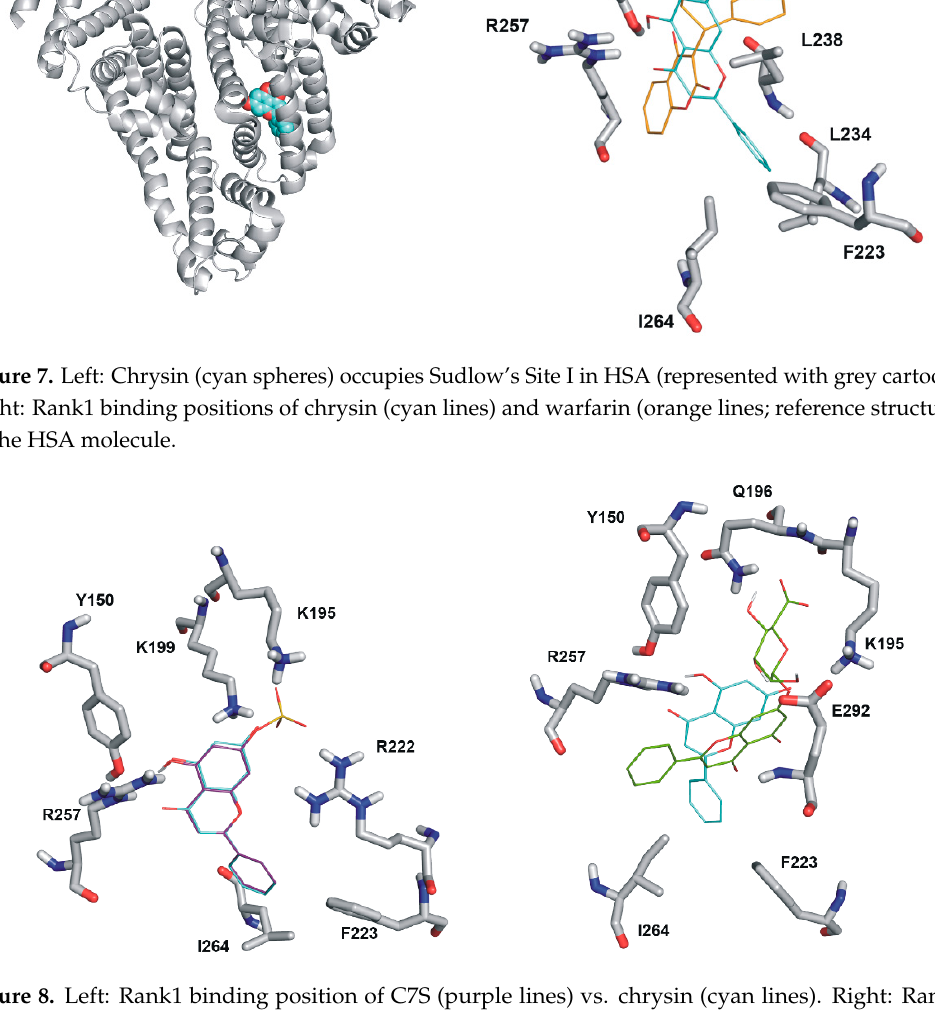
Figure 8. Left: Rank1 binding position of C7S (purple lines) vs. chrysin (cyan lines). Right: Rank1 binding position of C7G (green lines) compared to chrysin (cyan lines).